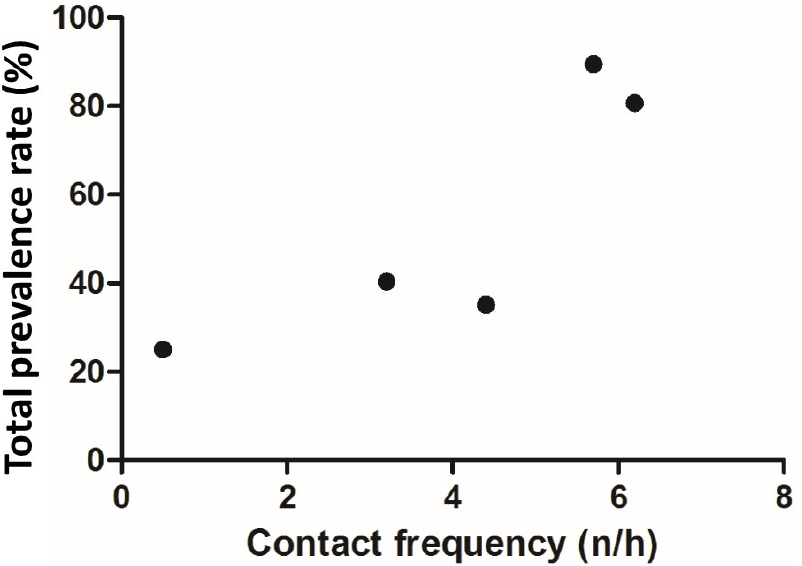
Figure 3. Correlation between the contact frequency and total intestinal parasite prevalence rate. Table 4. Prevalence of intestinal parasites during different seasons.